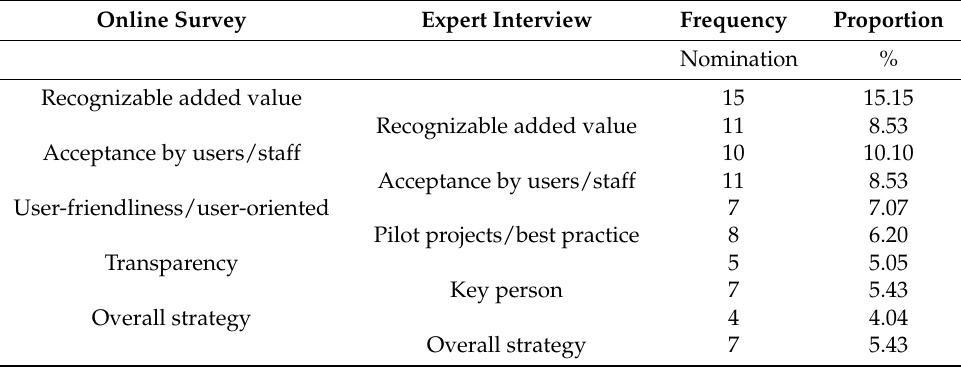
Table 6. Comparison of expert testimonies and survey